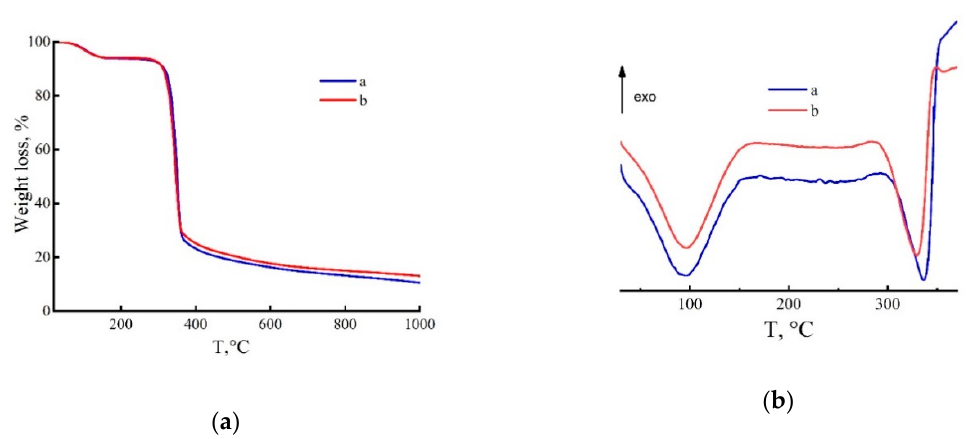
Figure 9. TGA curves ( a ) and thermograms ( b ) of cellulose fibers spun into IBA at 25 °C (a) and 70 °C (b), water washing and drying.